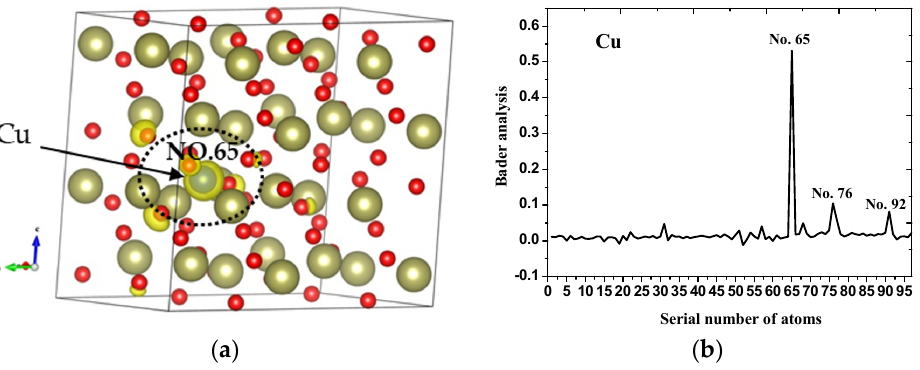
Figure 2. ( a ) Charge density difference of Cu (+2) (red and brown spheres represent O ions and Hf ions, Cu ion is wrapped in yellow); ( b ) graph representing the modified Bader analysis of Cu